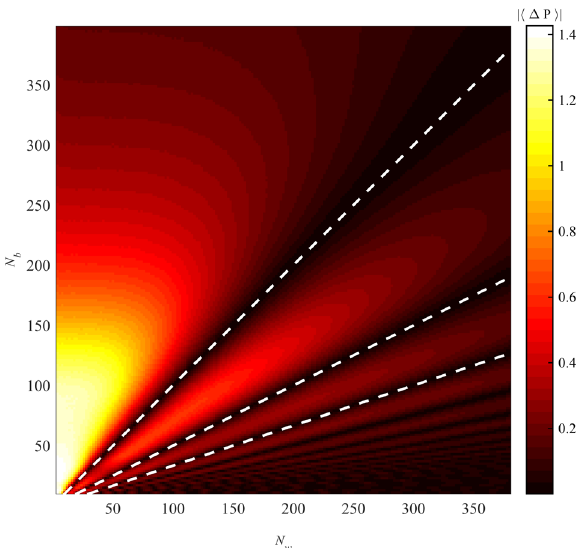
Figure 6. Absolute values of average total power difference be- tween original and rotated components | 〈 D P 〉 | as a function of samples per cycle N and window size N of moving average (see b w text for details).